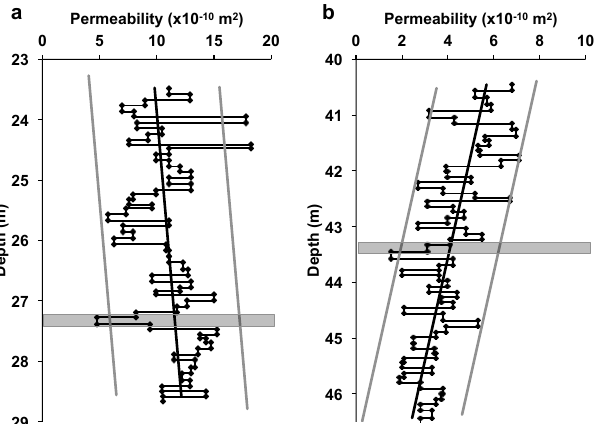
Figure 3. The permeability profiles from the 2009 NEEM firn core, near (a) ice layer 1, (b) ice layer 2, where gray bars indicate ice layer samples. The black line is a linear fit to the permeability measurements, and the gray lines indicate the upper and lower bounds of the 95% prediction interval, calculated based on the permeability.